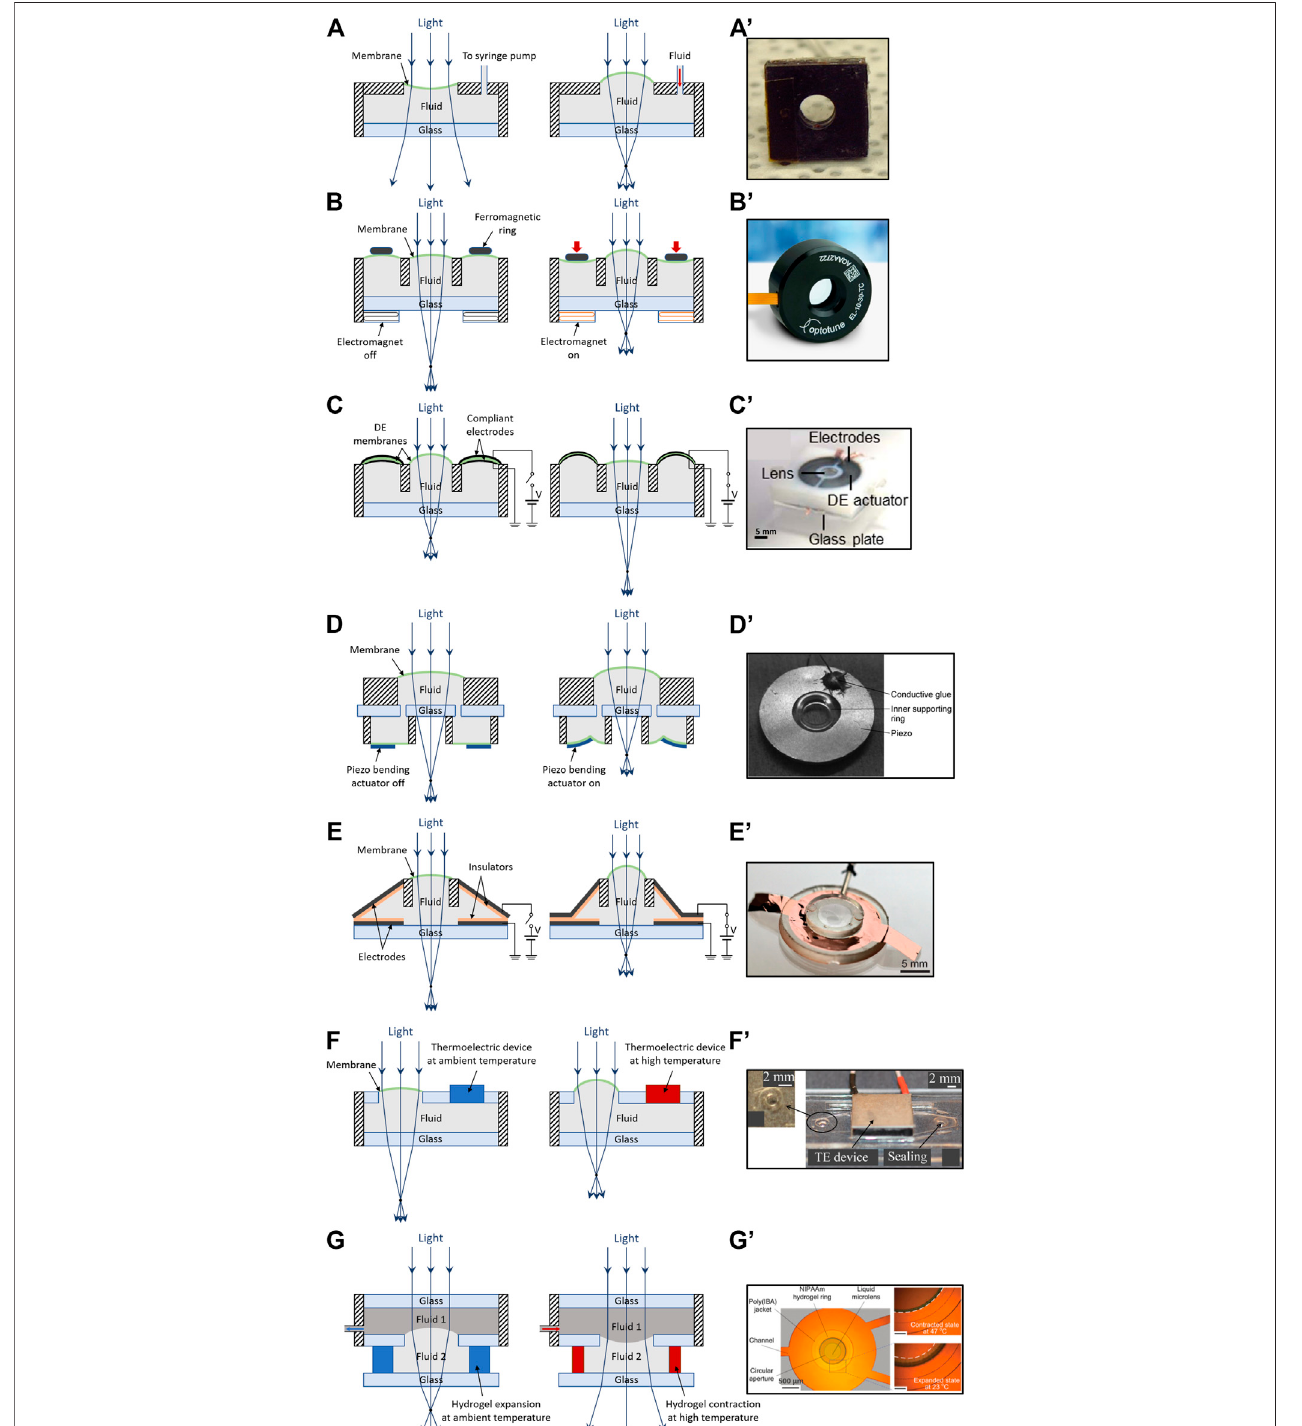
FIGURE 5 | Hydraulically shaped lenses. Structures and principles of operation (left) and photos of examples (right) , for different actuation strategies: (A) schematicofalenspressurizedbyanexternalpump; (A 9 ) prototypesample,reproducedwithpermissionfrom(Agarwaletal.,2004); (B) schematicofalenspressurized byanelectromagneticactuator; (B 9 ) commercialproductbyOptotune, adaptedfrom(Optotune, 2021); (C) schematicofalensdepressurizedbyatoroidalDEactuator; (C 9 ) prototype sample, reproduced with permission from (Wei et al., 2014); (D) schematic of alens pressurized by a piezoelectric bending actuator; (D 9 ) prototype sample, reproduced with permission from (Schneider et al., 2008); (E) schematic of a lens pressurized by an electrostatic zipping actuator; (E 9 ) prototype sample, reproduced with permission from (Hartmann et al., 2020); (F) schematic of a lens pressurized by an electro-thermal expansion of the lens fl uid; (F 9 ) prototype sample, reproduced with permission from (Ashtiani and Jiang, 2013); (G) schematic of a lens meniscus deformed by an electro-thermal contraction of a polymer; (G 9 ) prototype sample, reproduced with permission from (Dong et al., 2006).